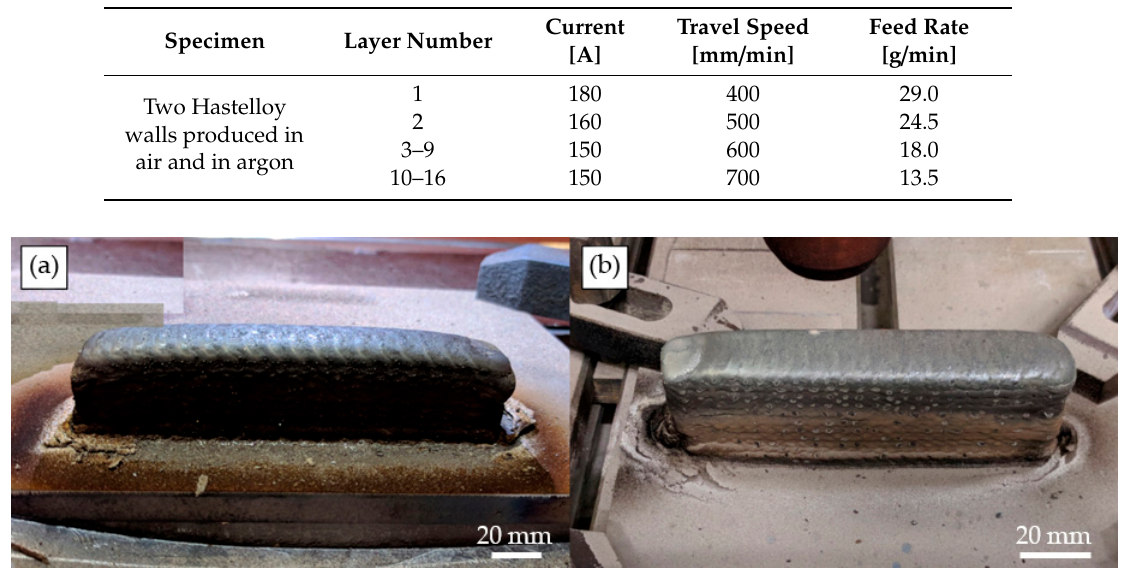
Table 3. Fabrication parameters for Hastelloy C-22 wall produced in air and in argon atmosphere.